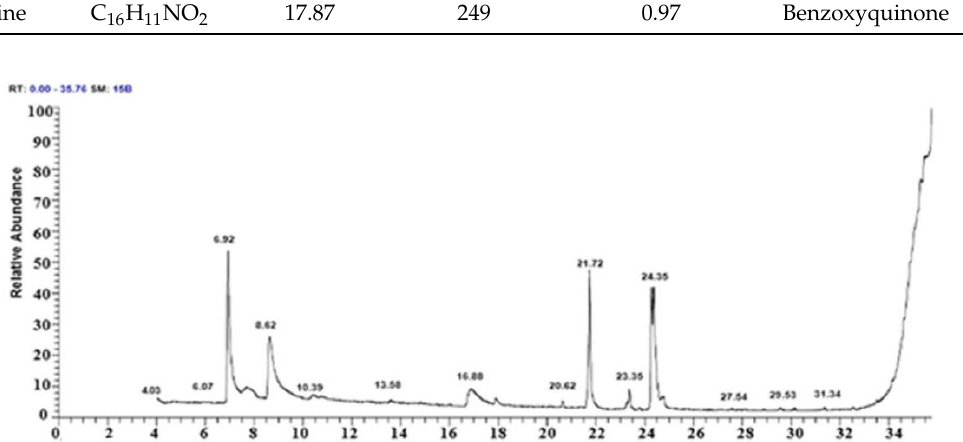
Figure 1. GC-GC-MS spectrum of Roselle ethanolic extract. Three major peaks were identified: a cyclopentane carboxylic acid peak at 6.92 min, an ethyl palmitate peak at 21.72 min, and a linoleic acid peak at 24.35 min.